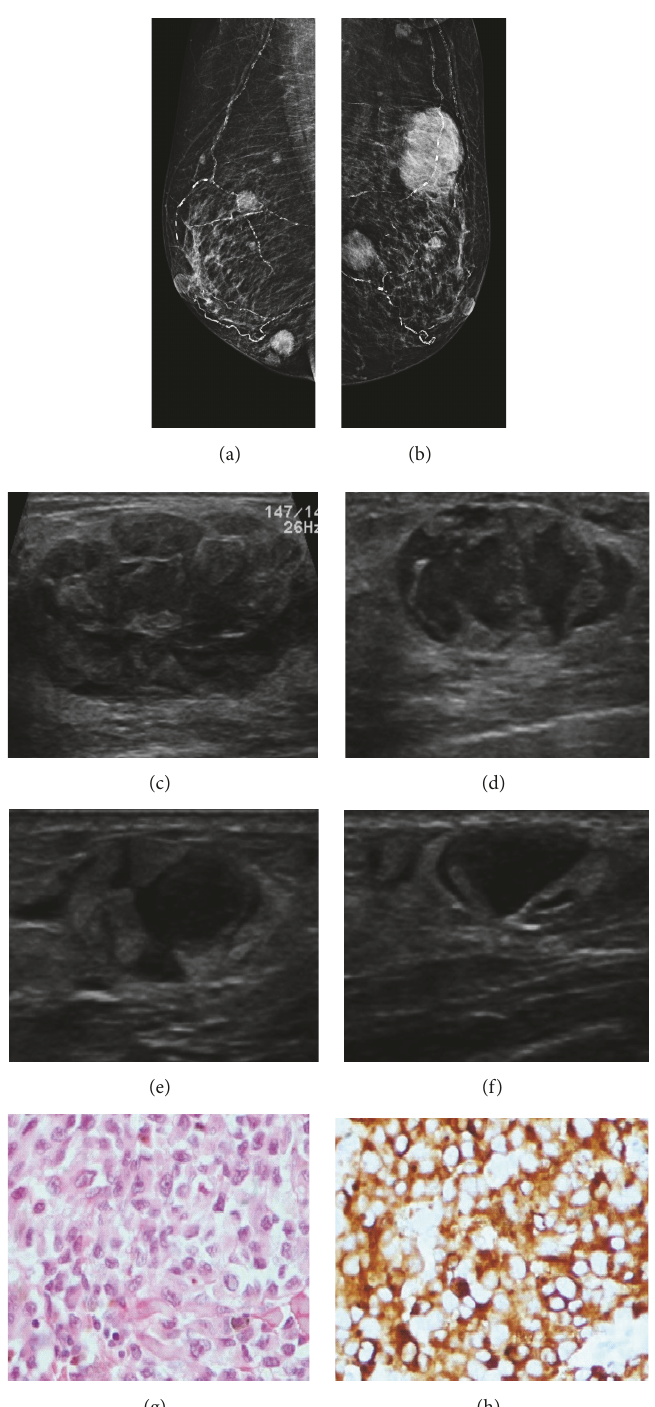
Figure 7: Case 7. A 71-year-old woman with malignant melanoma. Two years after diagnosis, the patient presented with a palpable mass in the left breast. Mammogram showed many oval masses with circumscribed margins ( a–b ). These findings were corroborated on ultrasound, exhibiting oval masses with indistinct and microlobulated margins and a heterogeneous echo pattern ( c–f ). Edema was also evident ( e–f ). Metastatic melanoma to the breast was confirmed following a histopathological analysis of the breast specimen. HE staining and immunohistochemistry analysis of the metastases. HE staining revealed the malignant cells in the breast tumor ( g ), and the immunohistochemistry analysis indicated that the cells were positive for HMB45 ( h